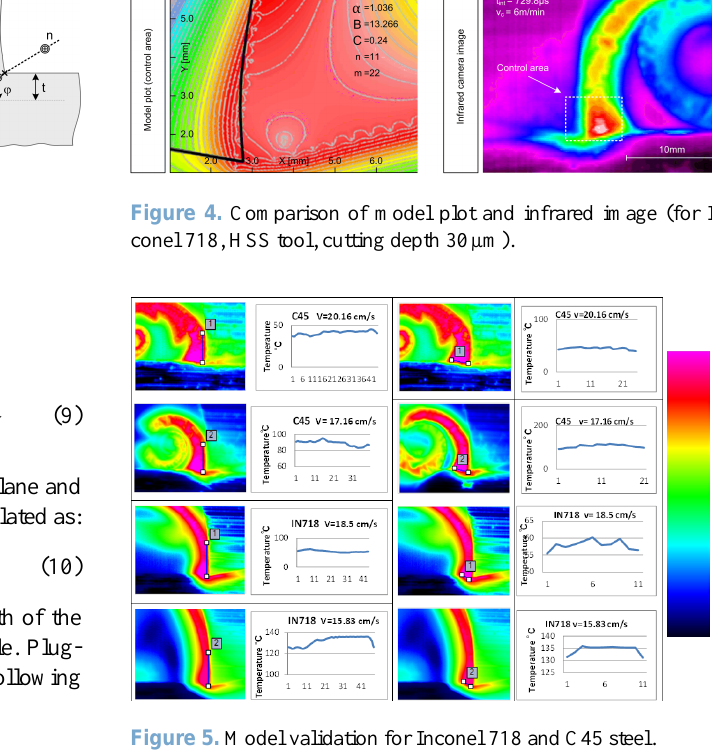
Figure 5. Model validation for Inconel 718 and C45